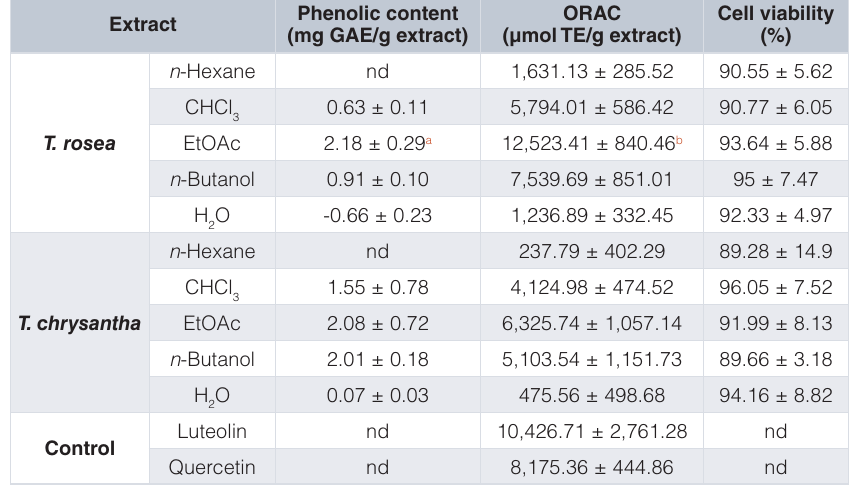
Table 2. Total phenolic content, ORAC activity and cell viability in extracts obtained from the inner bark obtained from T. chrysantha and T. rosea .